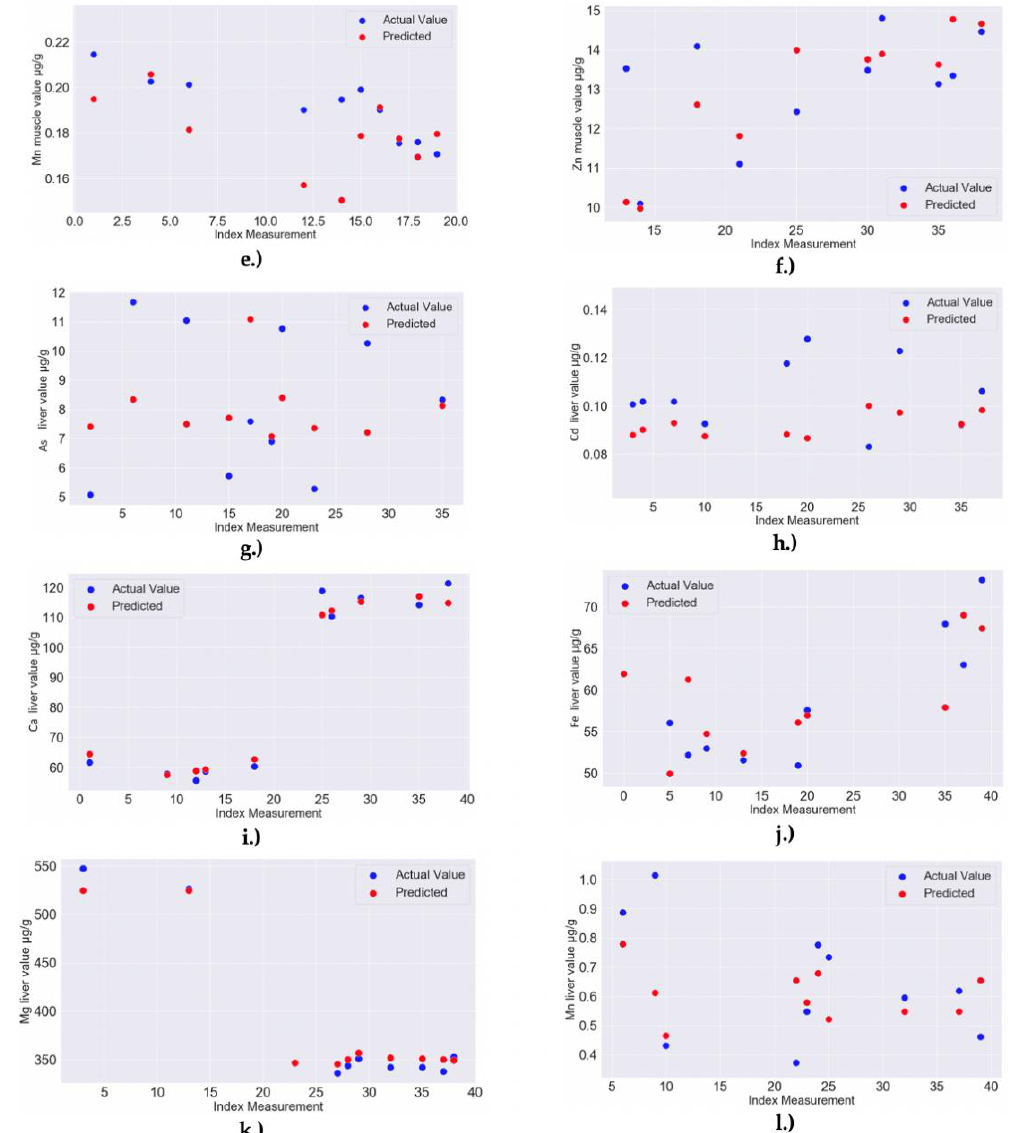
Figure A4. Prediction of heavy metal concentration for turbot muscle and liver tissues—actual values vs. predicted value for first group non-linear tree-based RF prediction models 21–30. (( a ). prediction for As concentration in muscle; ( b ). prediction for Cd concentration in muscle; ( c ). prediction for Cu concentration in muscle; ( d ). prediction for K concentration in muscle; ( e ). prediction for Mn concentration in muscle; ( f ). prediction for Zn concentration in muscle; ( g ). prediction for As concentration in liver; ( h ). prediction for Cd concentration in liver; ( i ). prediction for Ca concentration in liver; ( j ). prediction for Fe concentration in liver; ( k ). prediction for Mg concentration in liver; ( l ). prediction for Mn concentration in liver).